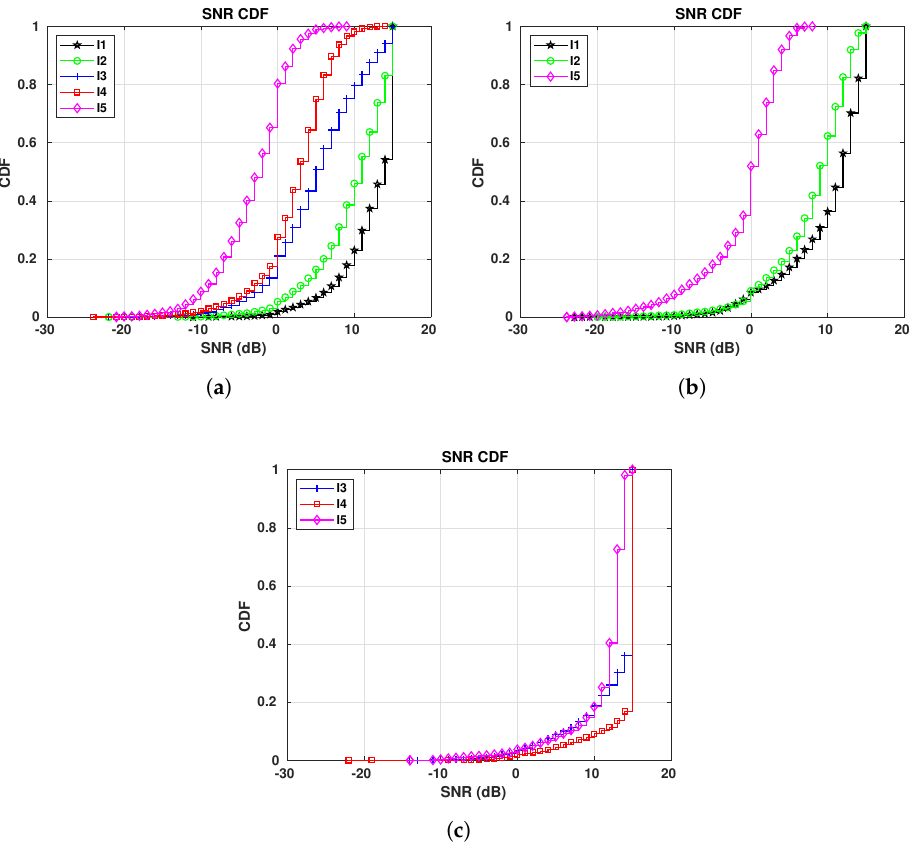
Figure 13. E5 SNR CDFs for all gateways in S1: I1 (16/01/2019 to 07/02/2019): − 16.96 ◦ C on average; I2 (22/12/2018 to 06/01/2019): − 9.45 ◦ C on average; I3 (25/10/2018 to 04/11/20018): − 0.15 ◦ C on average; I4 (30/09/2018 to 14/10/2018): 6.56 ◦ C on average; I5 (15/05/2019 to 22/05/2019): 13.22 ◦ C on average. ( a ) E5 SNR CDFs for GW1. ( b ) E5 SNR CDFs for GW2. ( c ) E5 SNR CDFs for